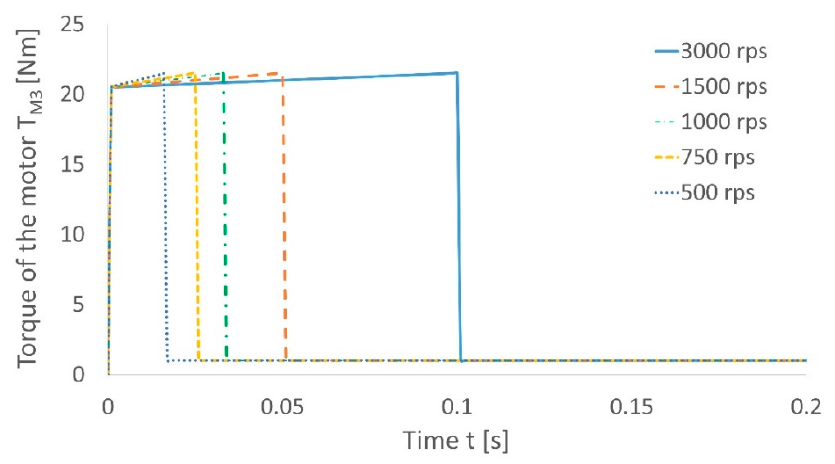
Figure 11. Characteristic curve of the WDU drive motor torque for rotational acceleration ε = 500 rev/s 2 and various maximum rotational speed ω .